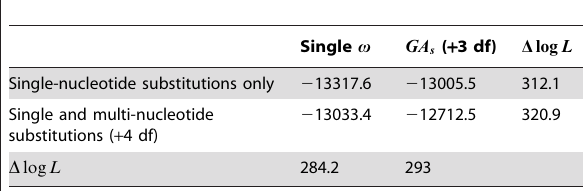
Table 6. The effects of modeling multi-nucleotide instantaneous substitutions and multiple